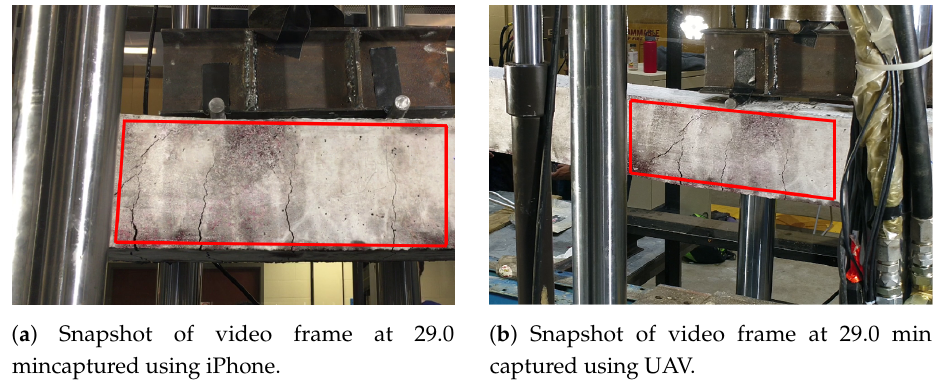
( a ) Snapshot of video frame at 29.0 ( b ) Snapshot of video frame at 29.0 min mincaptured using iPhone. captured using UAV. Figure 11. Original frame of the video at 29.0 min recorded using iPhone and UAV.